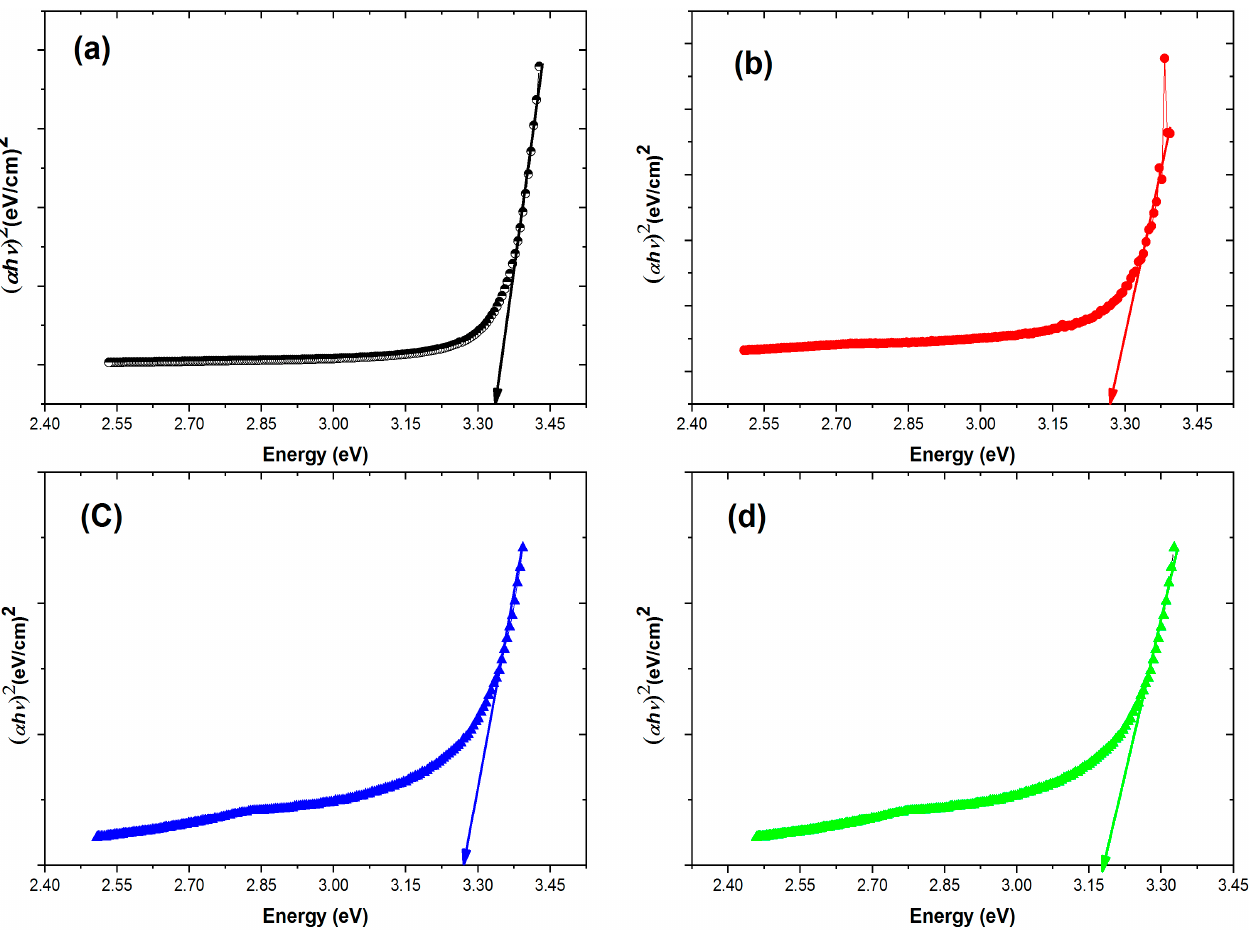
Table 3. Optical bandgap of ZnO, Co-added, Gd-added, and Co/Gd ZnO nanoparticles.